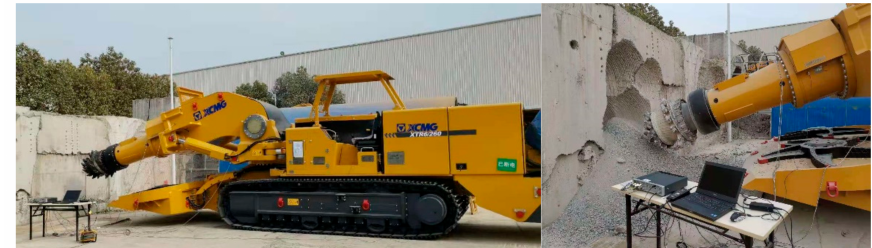
Figure 7. Experimental environment of tunneling operation.